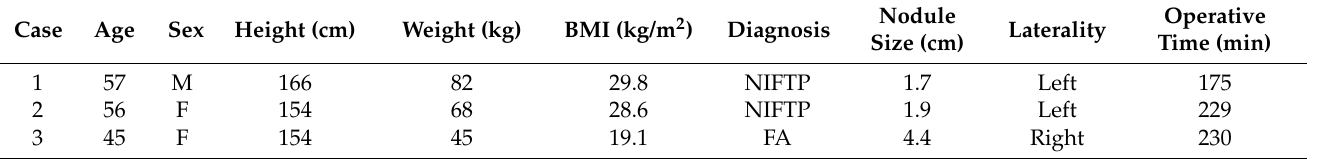
Table 1. Patient characteristics.